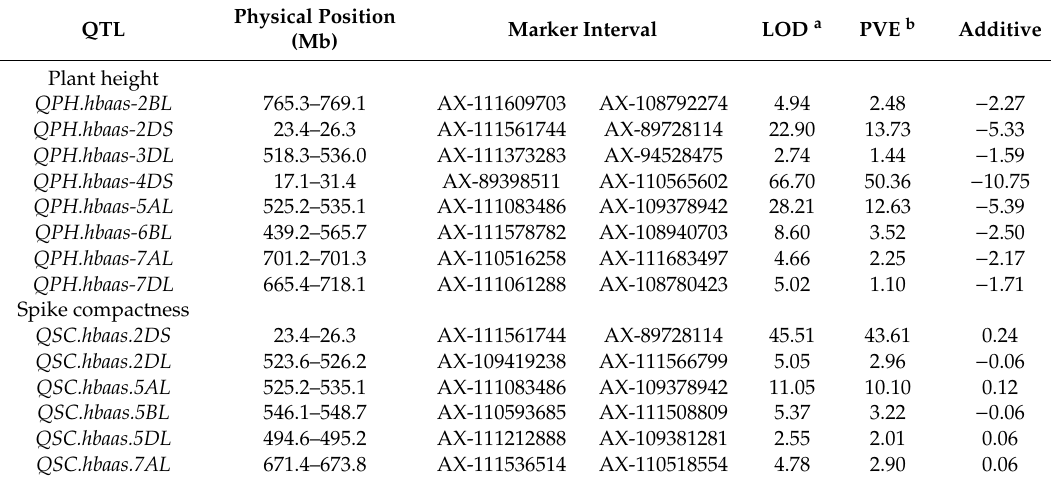
Table 7. QTL identified for plant height and spike compactness in the Jingzhou66 and Aikang58 DH population using inclusive composite interval